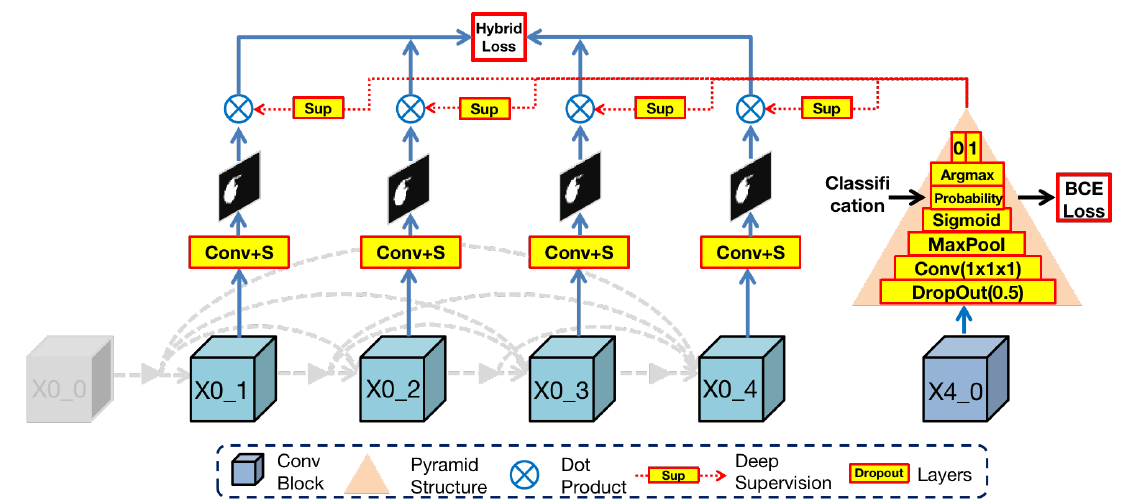
Figure 5. Illustration of the False Positives Classification (FPC)